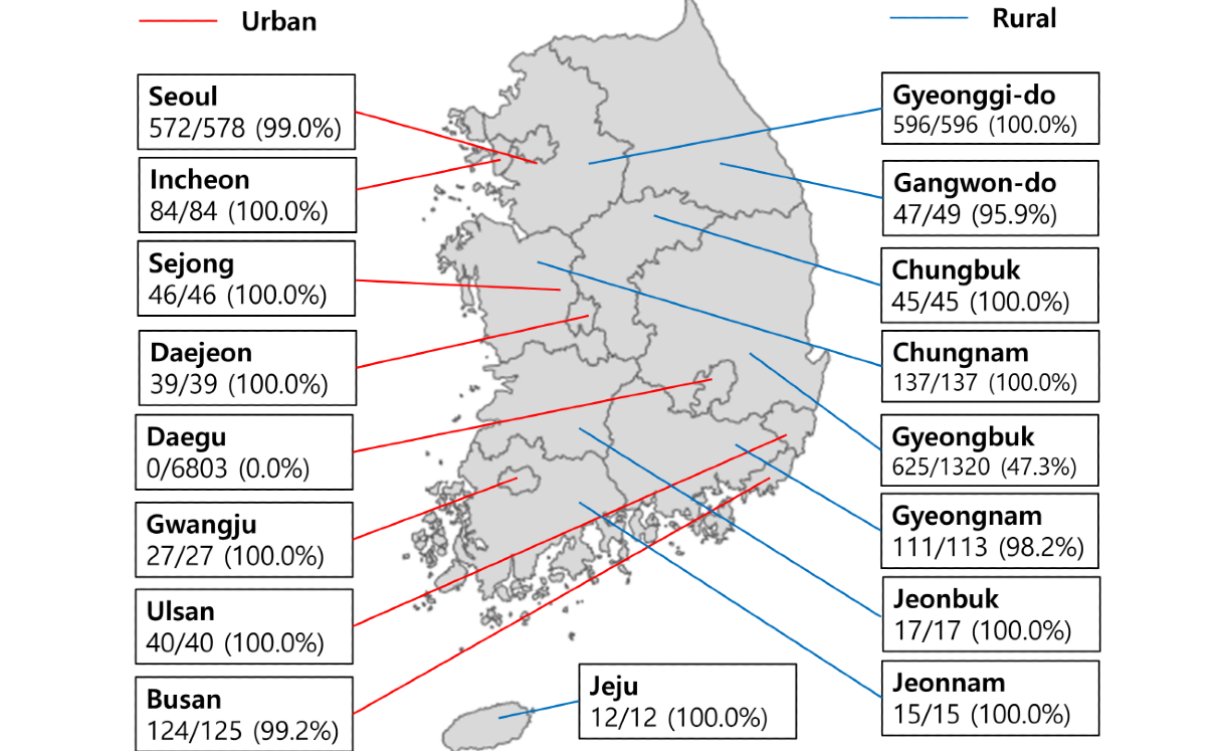
Figure 1. Our study population in each region (number of our study population/number of total patients with confirmed COVID-19). Of 9550 patients with confirmed COVID-19, there were 2134 patients with confirmed COVID-19 who completed the epidemiological